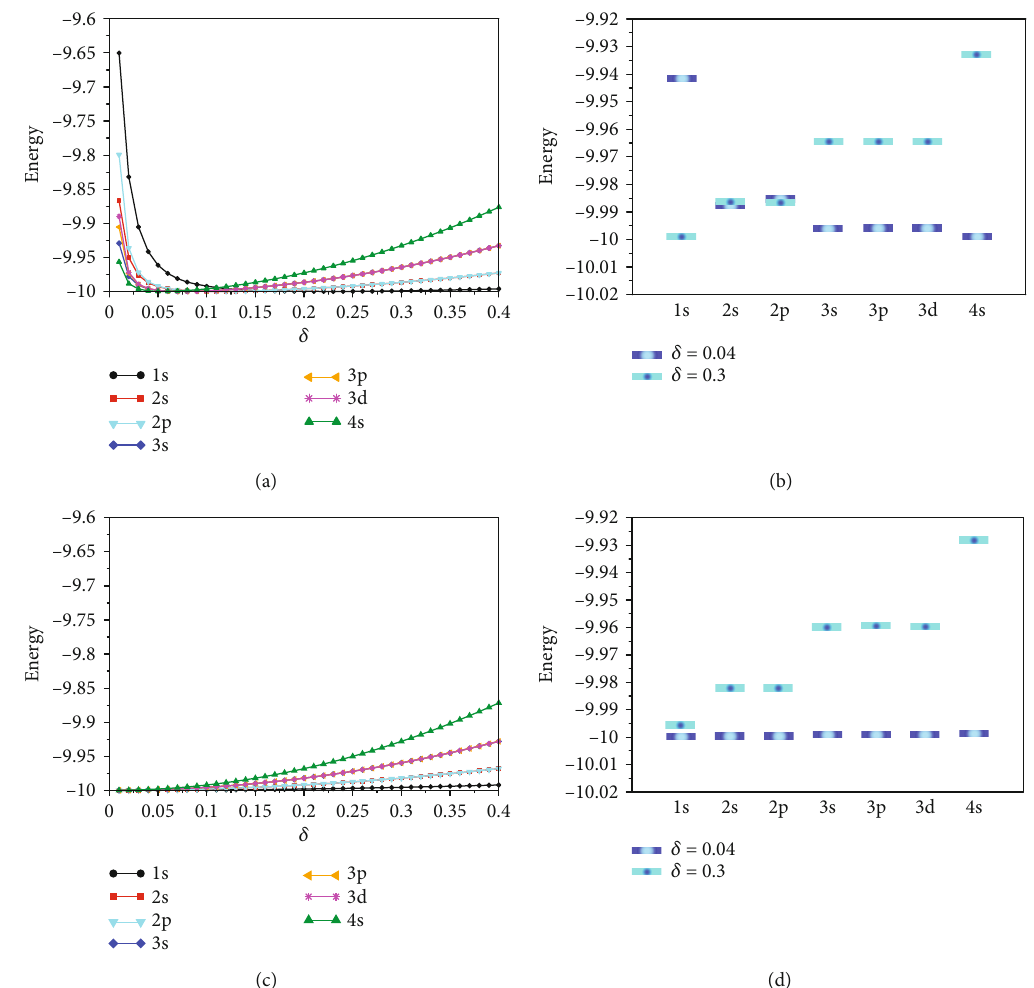
Figure 1: (Color online). The variation of energy level as a function of screening parameter δ for quantum states in (a, b) the parameters = 0 : 01 , V ′ = 0 : 05 , S = 0 : 025 , and S ′ M = 10 , V 0 0 0 0 : 045